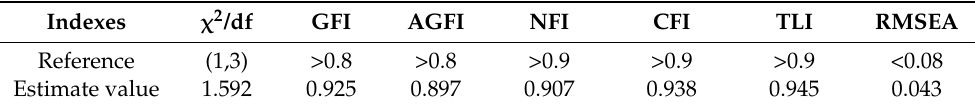
Table 8. After modified model-fit